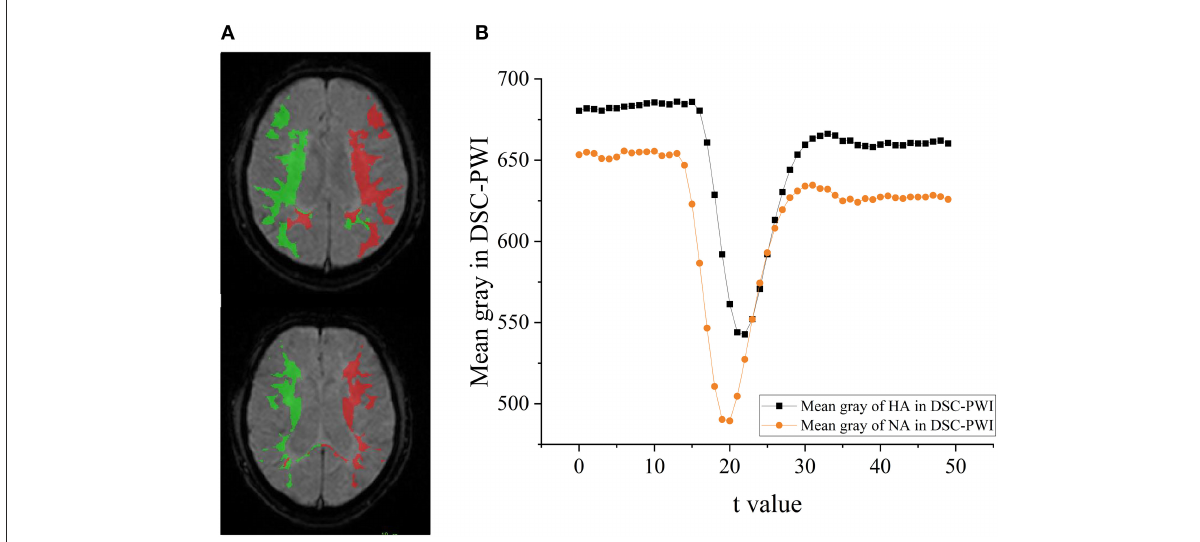
FIGURE10 The difference of HA and NA in the DSC-PWI image. (A) The ROIs of HA and NA in the DSC-PWI image, the HA is shown in red and the NA is shown in green. (B) The mean time-intensity curve I ( t ) of HA and NA, the black represents the mean I ( t ) of HA, and the orange is that of